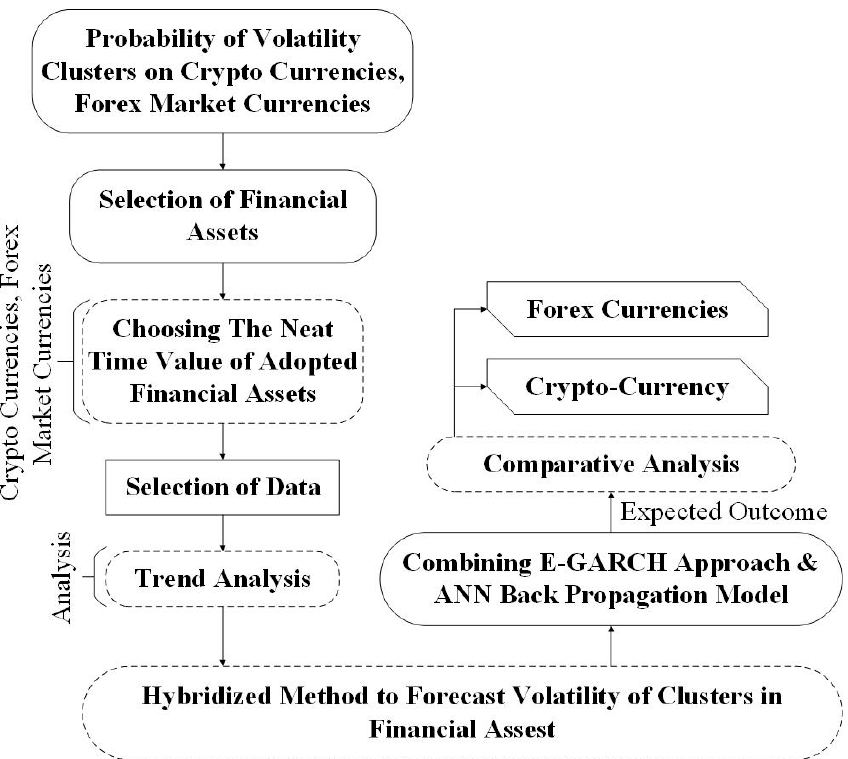
Figure 1. Architecture of Research Forecasting Model.